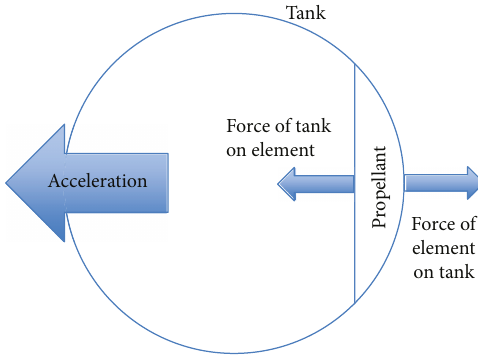
Figure 9: Minimum energy fl uid distribution with steady acceleration